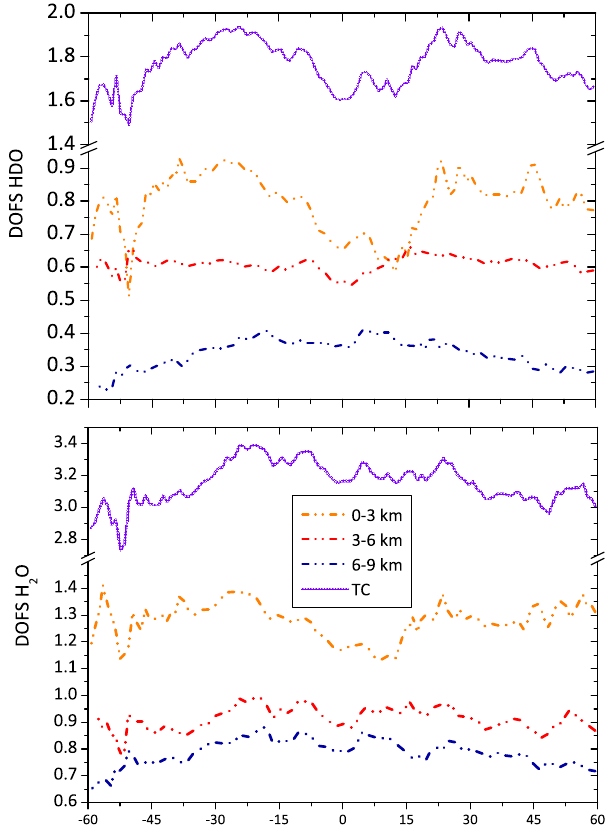
Fig. 6. DOFS for total columns (purple line), and for the partial columns 0–3km (dashed orange line), 3–6km (dashed red line), and 6–9km (dashed blue line). For HDO (top panel) and H 2 O (bottom